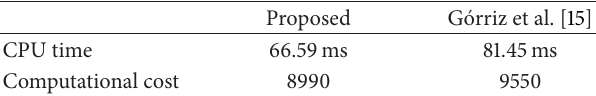
Table 3: CPU time and computational cost comparison per single frame